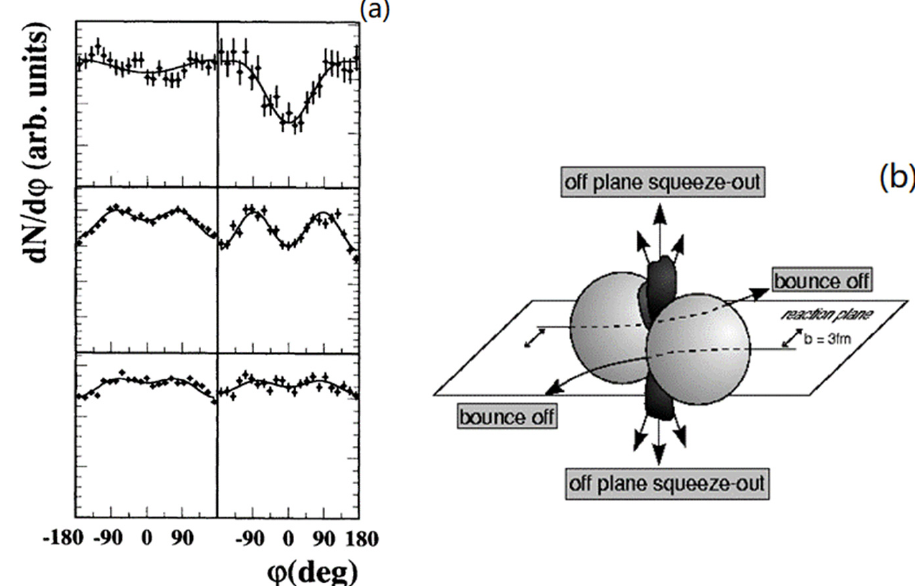
Figure 6. ( a ) Azimuthal distributions of positively charged pions for peripheral, semi-central and central collisions (from top to bottom) measured in Au+Au collisions at 1A GeV [37]. The ordinate is linear starting at zero. Left column: π + in the range 160 < p T < 260 MeV/c. Right column: π + in the range 260 < p T < 600 MeV/c. Solid lines: fits to the data with cos( φ ) and cos(2 φ ) terms. φ = 0° and φ = ±180° represent emission of pions parallel to the reaction plane and φ = ±90° corresponds to emission of pions perpendicular to the reaction plane. ( b ) Illustration of the particle emission pattern for semi-central collisions at intermediate beam energies perpendicular to the reaction plane (“off-plane squeeze-out”) and parallel to the reaction plane (“bounce